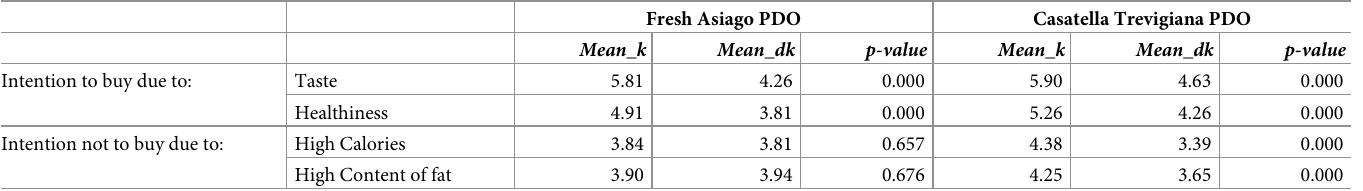
Table 3. Pair comparison of purchase (or not purchase) reasons between consumers who know the product ( Mean_k ) and those who don’t ( Mean_dk